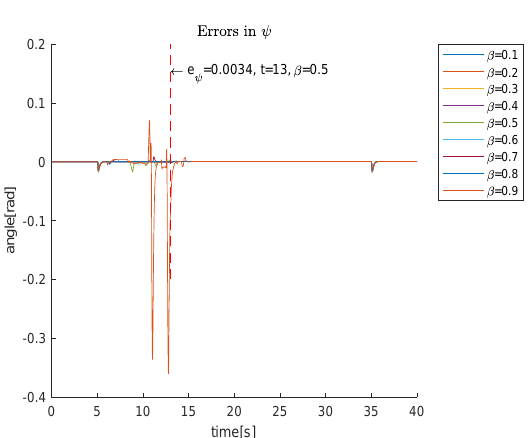
Figure 8. Euler angle errors in θ .